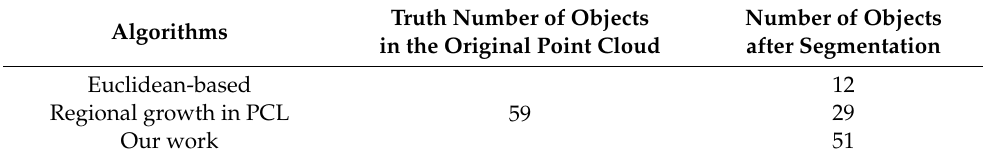
Table 1. The number of objects before and after segmentation.